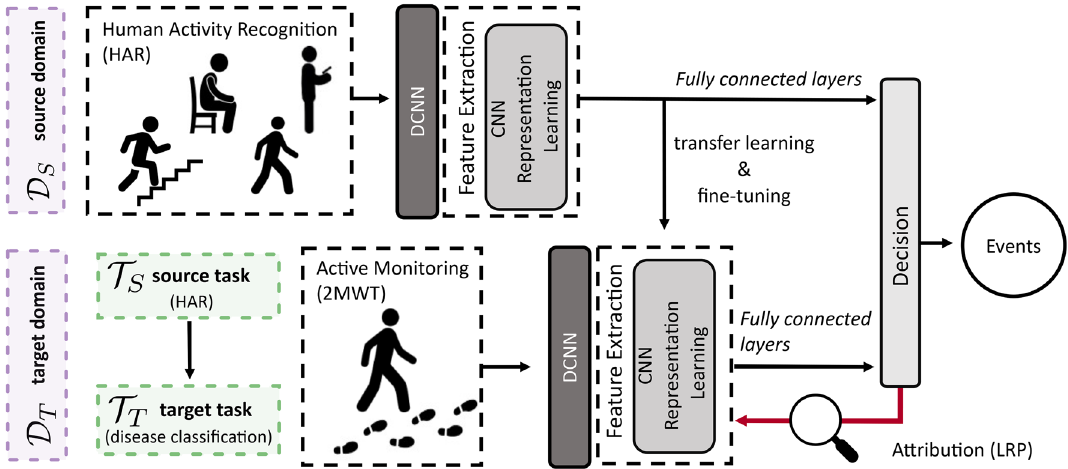
Figure 1. Schematic of proposed smartphone-based remote disease classification approach. First, open-source datasets ( D S ) were utilised to learn a HAR classification task ( T S ) with a Deep Convolutional Neural Network (DCNN). Learned activity information was then subsequently transferred using the transfer learning (TL) framework, where a portion of the DCNN model is retrained on the FL datatset ( D T ), and parameters are fine- tuned towards the application of a disease recognition task ( T T ). DCNN model decisions can then be visually interpreted using attribution techniques, such as layer-wise relevance propagation (LRP), which aim to map the patterns of an input signal that are responsible for the activations within a network, and hence uncover pertinent MS disease-related ambulatory characteristics.